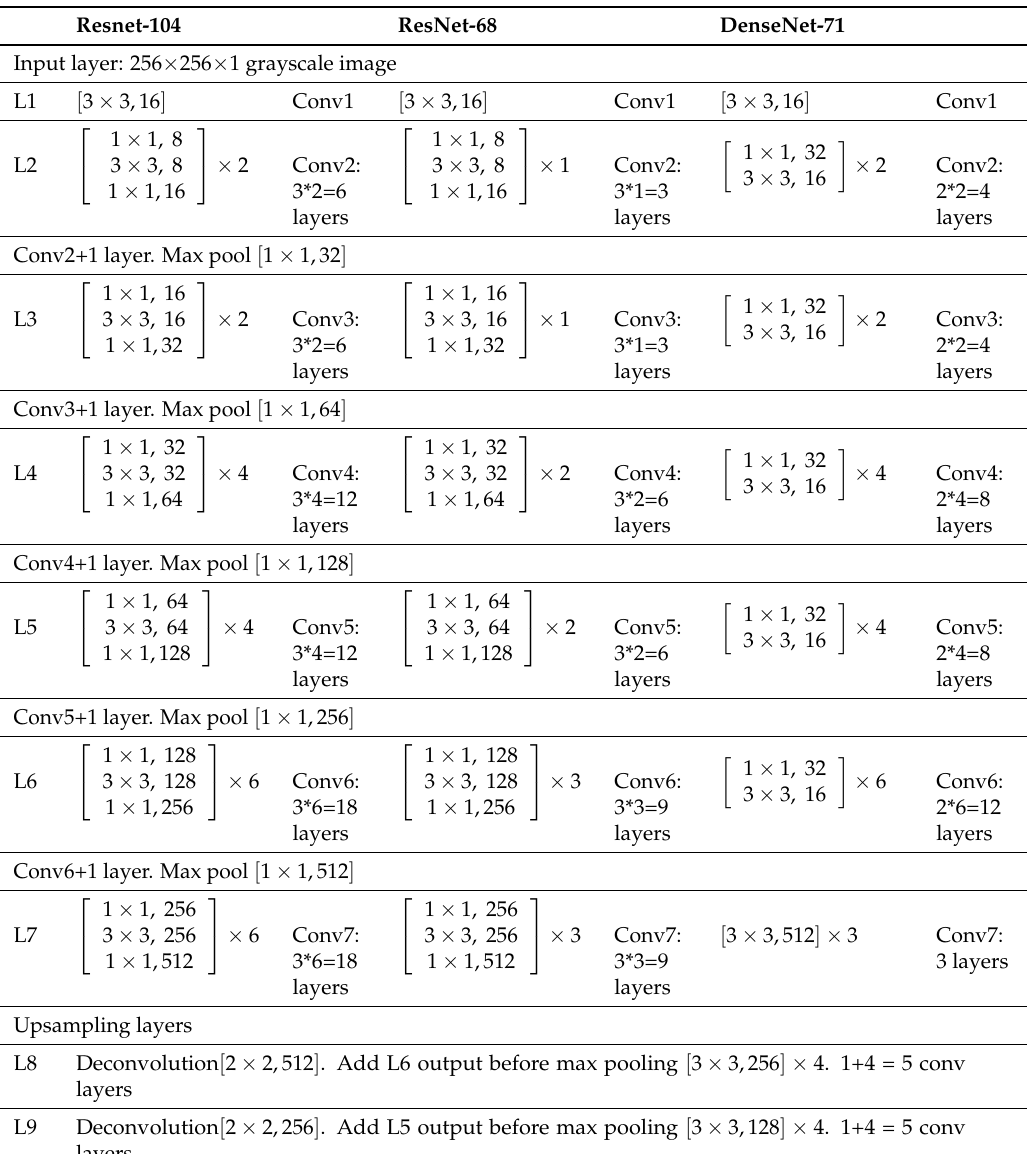
Table 1. Layers of convolutional neural network (CNN) architectures used for experiments. Resnet-104 ResNet-68